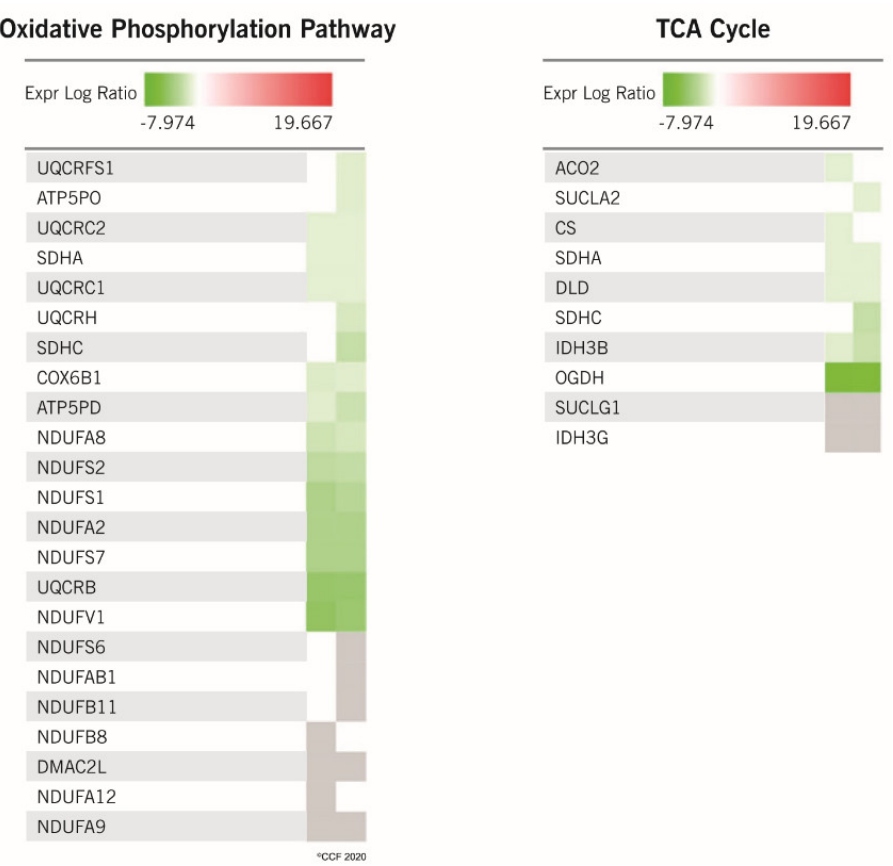
Figure 4. Heat map illustrating the expression of proteins associated with oxidative phosphorylation and tricarboxylic acid (TCA) cycle. Intensity of the color corresponds to the expression level of the proteins. Table 3. Deactivated pathways and upstream regulators affected in spermatozoa of cancer patient. Pathways Z Score * Oxidative Phosphorylation −3.46 Tricarboxylic acid (TCA) cycle II −2.45 Fatty acid β-oxidation I −2.00 Glycolysis I −2.24 Upstream regulators RICTOR 4.785 KDM5A 3.464 MAP4K4 3.162 TRAP1 2.433